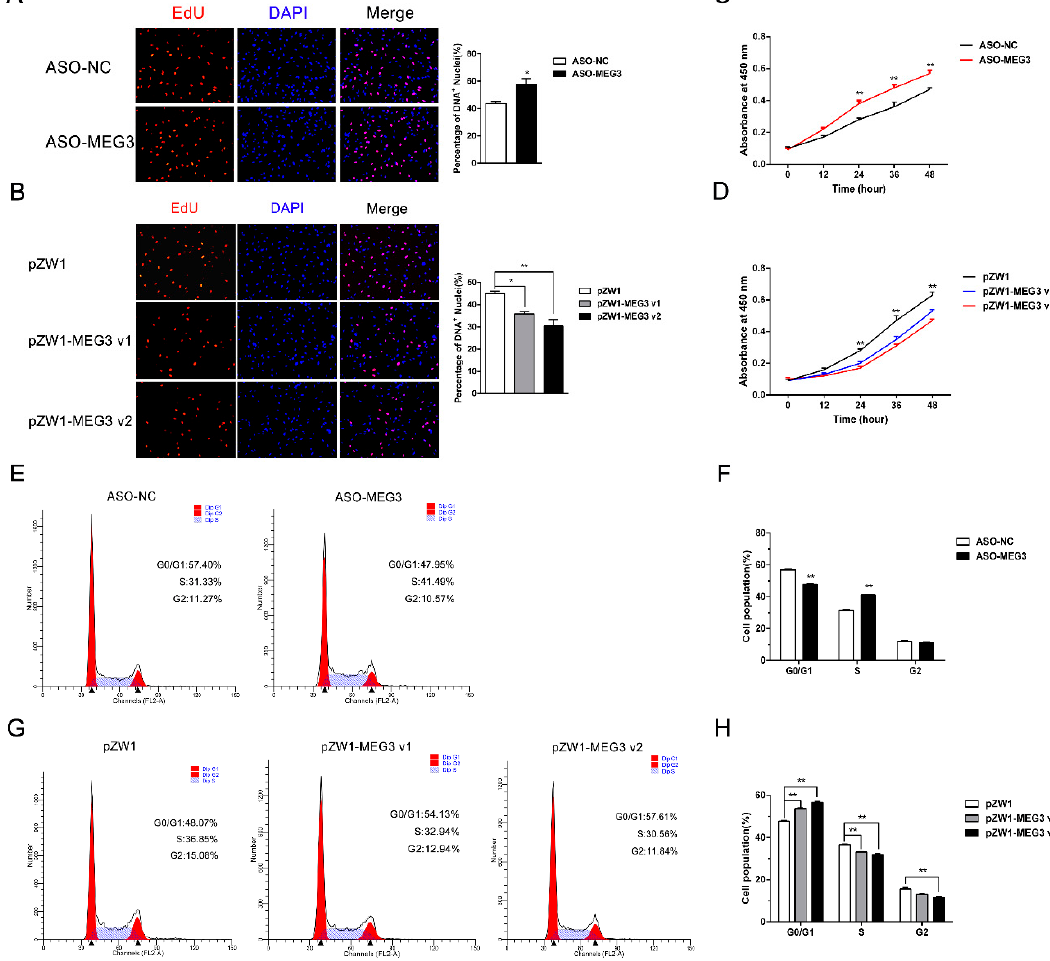
Figure 2. MEG3 inhibits myoblast proliferation. ( A , B ) EdU staining assays after MEG3 knockdown ( A ) or overexpression of the two MEG3 variants ( B ) showing the EdU incorporation in proliferous porcine satellite cells. The S phase of mitosis cells were stained with EdU. The nuclei were stained with DAPI. Scale bar: 50 μ m. ( C , D ) CCK-8 cell proliferation assays of porcine satellite cells suggested that MEG3 knockdown significantly promoted myoblast proliferation after transfection with antisense oligonucleotide (ASO)– MEG3 for 24, 36, and 48 h, compared with the negative control groups ( C ), while overexpression of MEG3 v1 or MEG3 v2 inhibited myoblast proliferation ( D ). ( E , G ) Flow cytometry analysis after MEG3 knockdown ( E ) or overexpression of the two MEG3 variants’ overexpression plasmids for 36 h ( G ). ( F , H ) Histogram bar graph summarizing the flow cytometry analysis showing the number of cells in each cell cycle phase. Statistical results showing that MEG3 knockdown significantly increased the percentage of S-phase cells ( F ), while MEG3 overexpression significantly decreased the percentage of S-phase cells ( H ). Error bars represent mean ± SEM of three biological replicates. Statistical significance of differences was assessed by Student’s t -test. * p < 0.05, ** p < 0.01. NC, negative control.